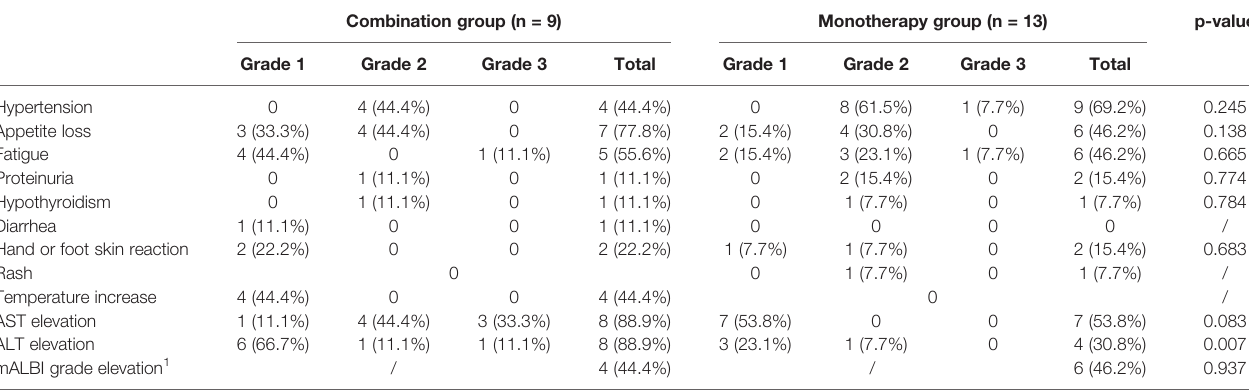
TABLE 5 | The types and grades of AEs in both